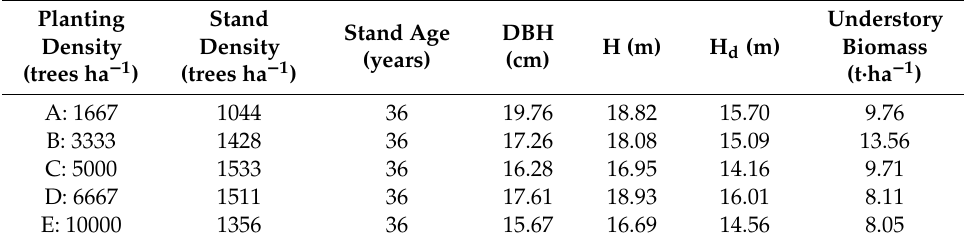
Table 1. The arithmetic mean diameter at breast height (DBH), mean height (H), dominant height (H d ), and understory biomass of stands with different planting densities.